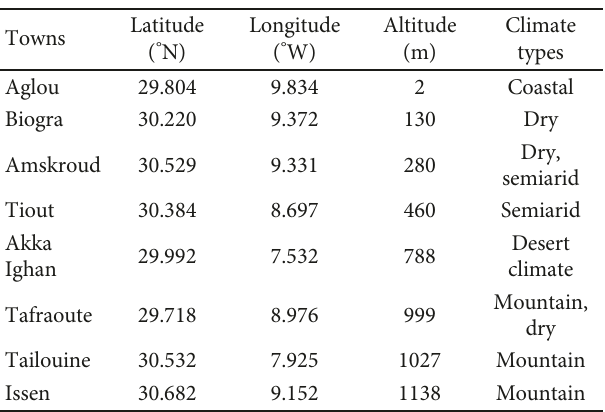
Table 2: The geographical data of the locations selected to test the network under di ff erent climatic conditions.